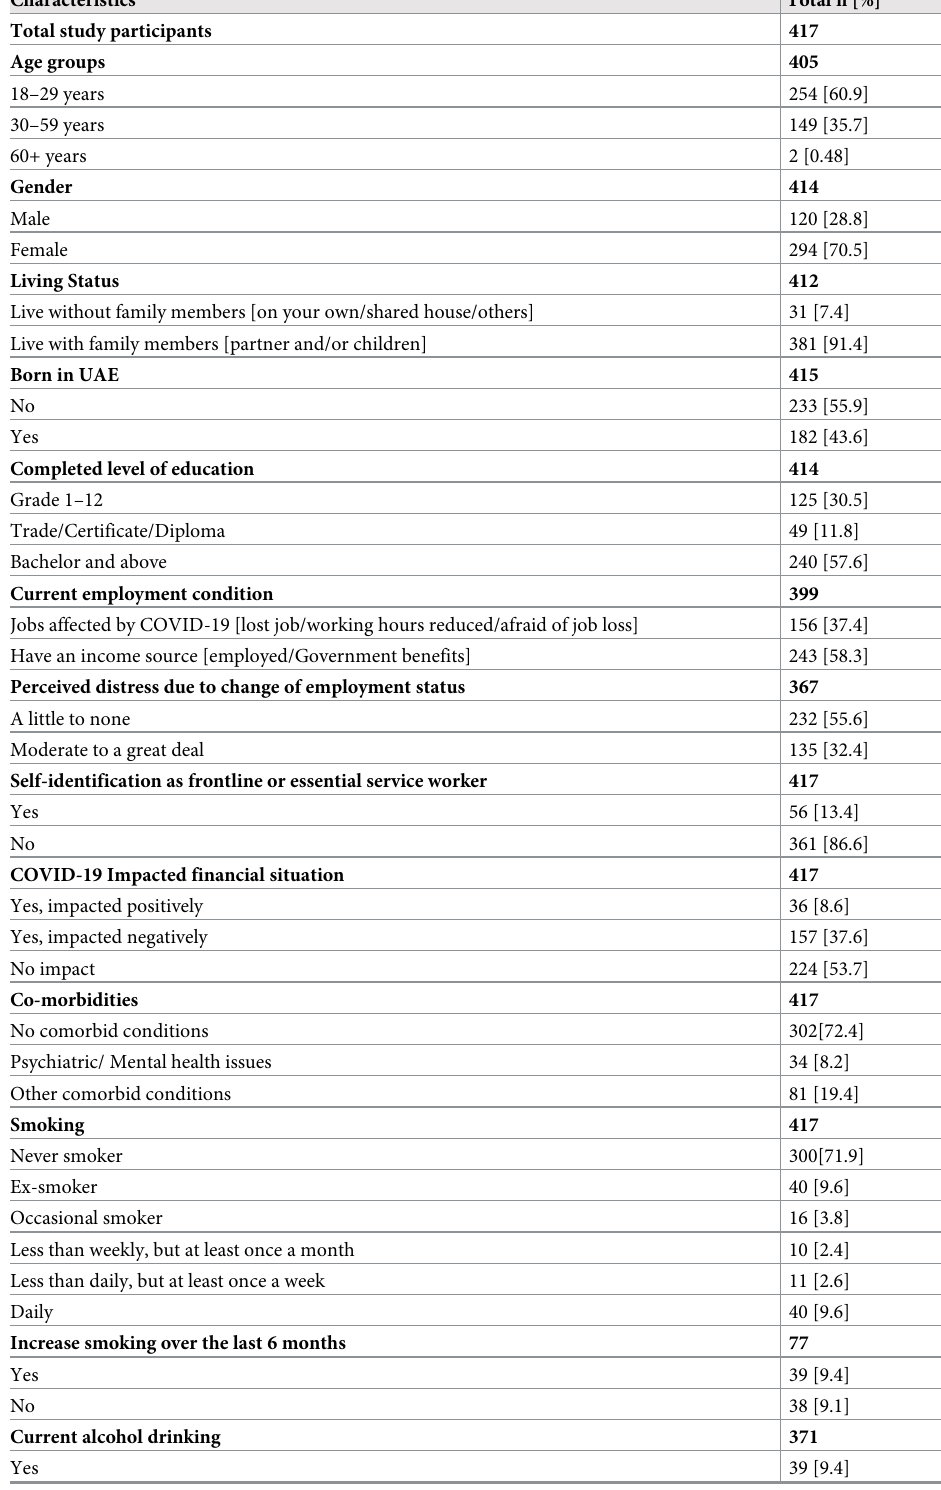
Table 1. Characteristic of the study population in UAE